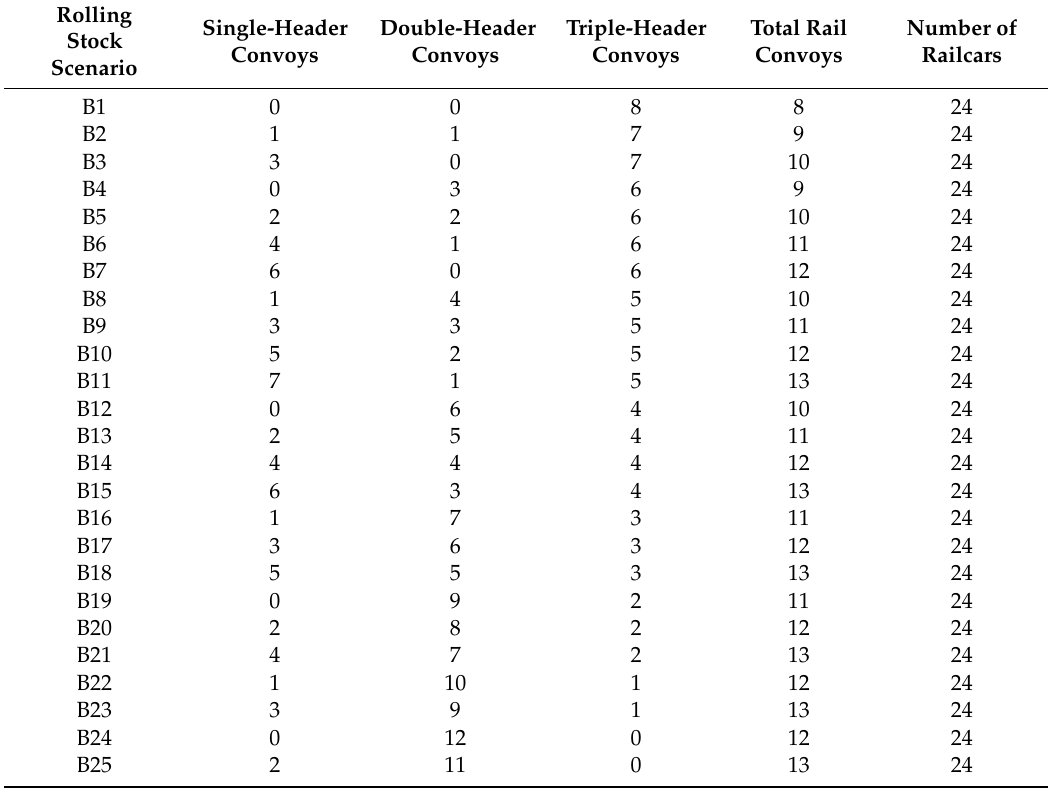
Table A1. Feasible rolling stock combinations in disrupted